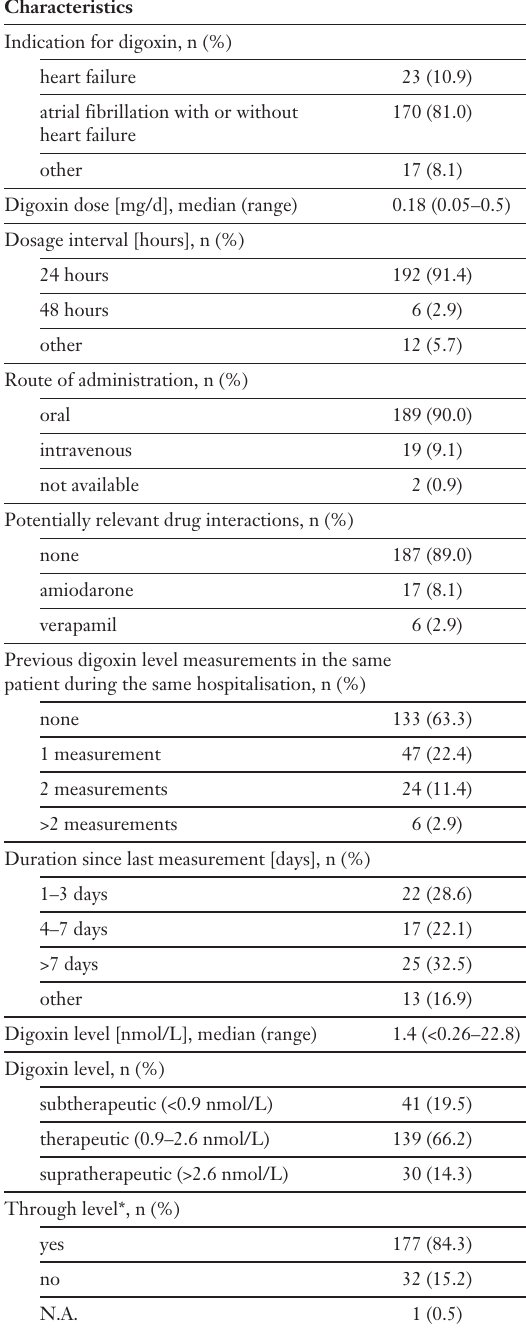
Performance charac- teristics of 210 digoxin level mea-